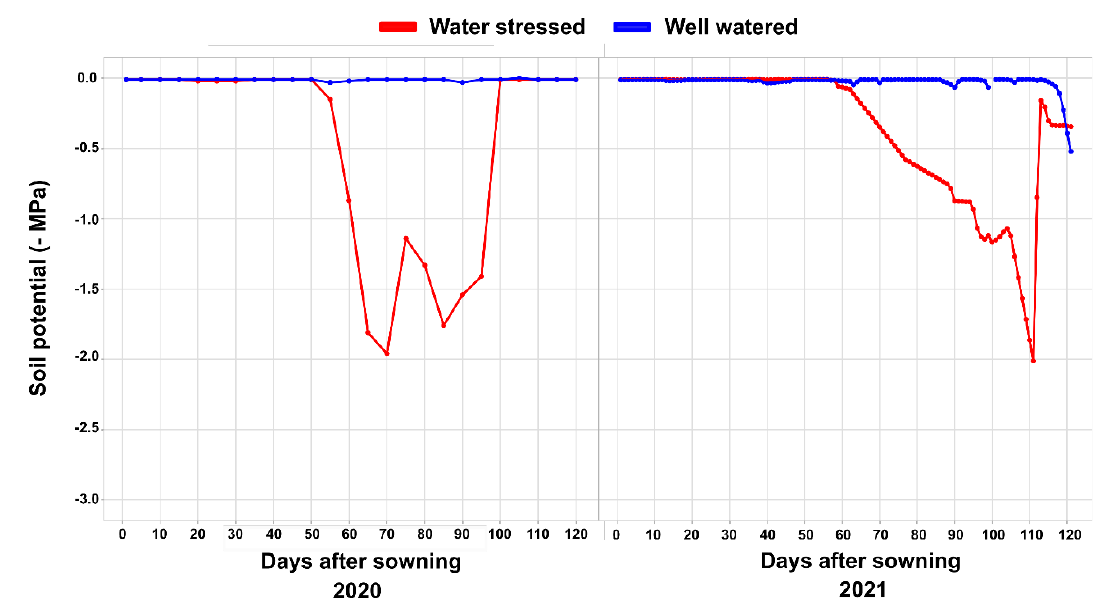
Figure 8. Soil water potential during the cultivation of popcorn lines under contrasting water conditions (WS and WW) in the 2020 and 2021 crop seasons.